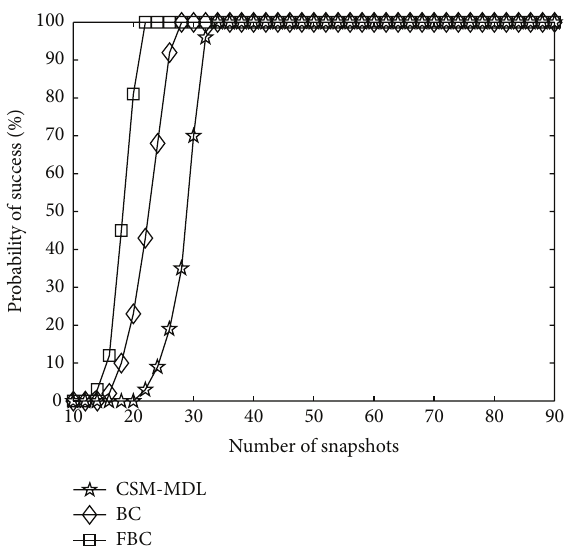
Figure 7: Probability of success versus number of snapshots for coherent signals.